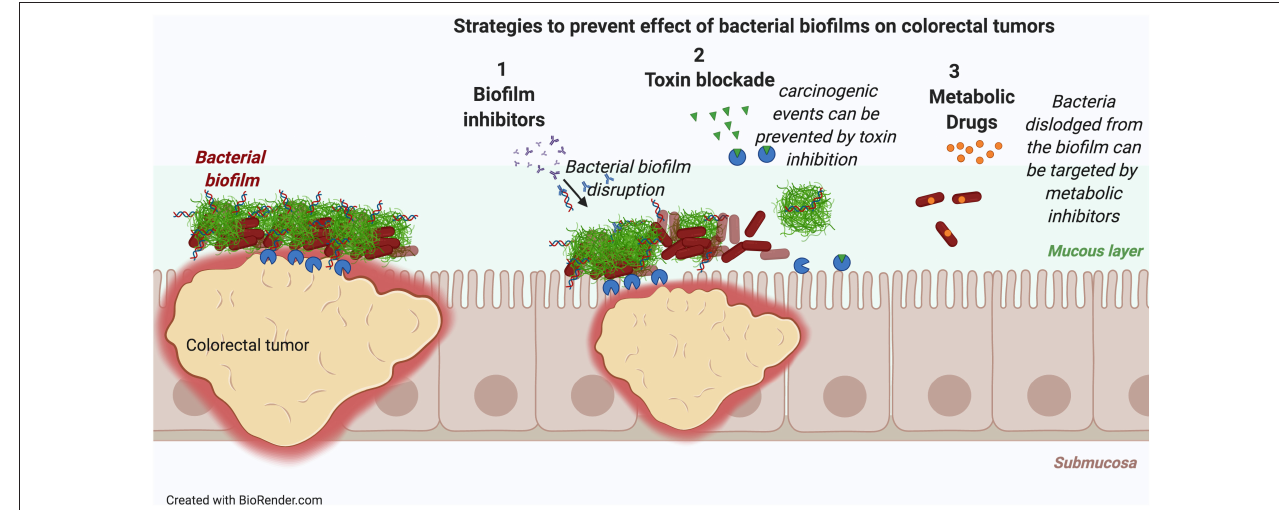
FIGURE 3 | Novel strategies to intercept colorectal cancer. Three novel strategies either alone or in combination could reduce carcinogenesis triggered in biofilm associated colorectal tumors: (i) Inhibition of biofilm formation to dissociate the biofilms from the tumors, (ii) inhibition of toxin production by biofilm forming bacteria, (iii) inhibition of biofilm-associated bacterial growth by metabolic